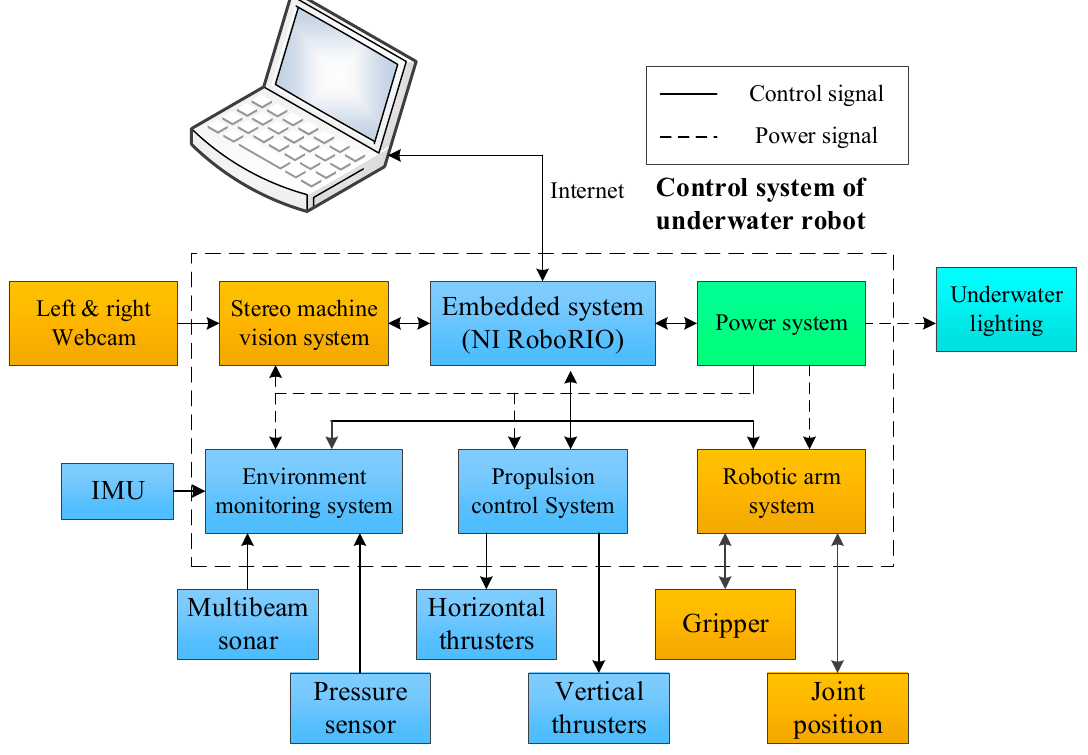
Figure 2. System architecture diagram.